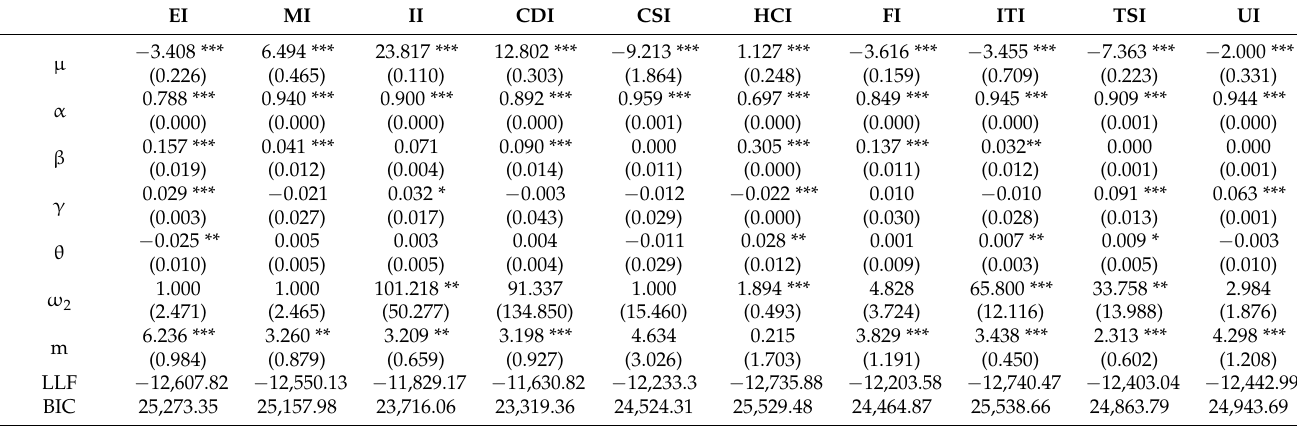
Table 12. GARCH-MIDAS regression results of EPU_JAP index on volatility spillover levels of various industries in China 10